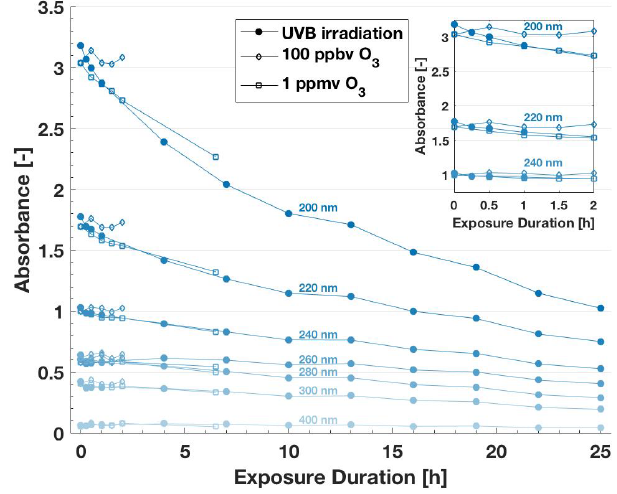
Figure 7. Wavelength-specific absorbance values from UV–Vis spectra of 20mgCL − 1 lignin solutions after atmospheric process- ing through UVB irradiation and exposure to O 3 . The insert zooms in on the section from 0 to 2h exposure duration. With increasing exposure duration, lignin’s absorbance decreases. Changes after ex- posure to 100ppbv O 3 are